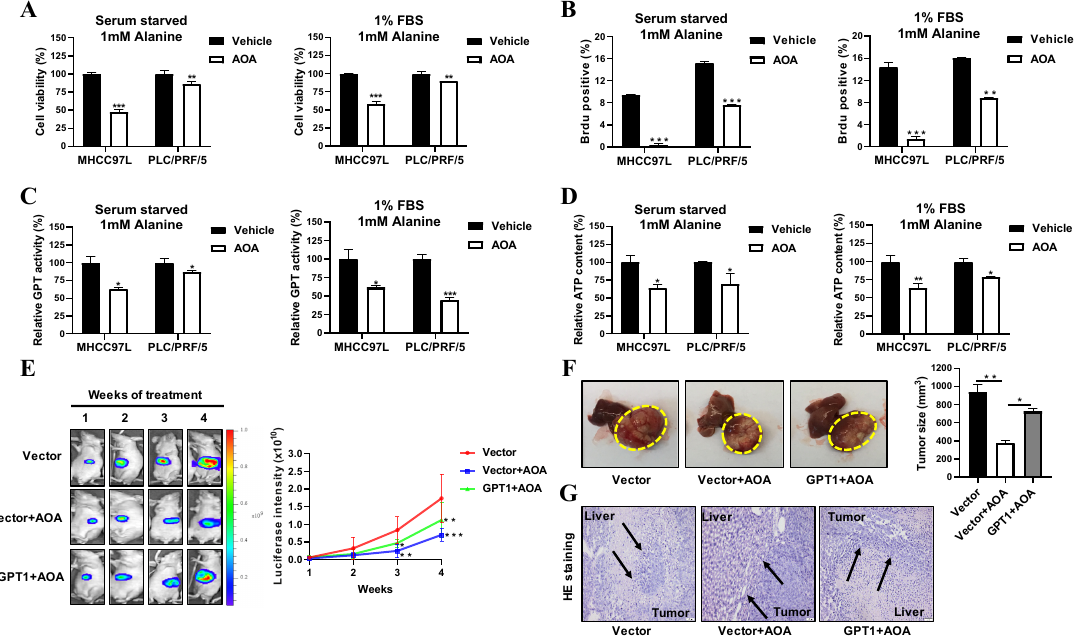
Figure 3. Inhibition of GPT1 with AOA (aminooxyacetate) potently suppressed alanine-mediated HCC growth. ( A ) The cell viability analysis of MHCC97L and PLC / PRF / 5 cells under alanine-rich conditions following AOA treatment for 24 h. ( B ) The BrdU incorporation analysis of MHCC97L and PLC / PRF / 5 cells under alanine-rich conditions following AOA treatment for 24 h. ( C ) The GPT activity levels of MHCC97L and PLC / PRF / 5 cells under alanine-rich conditions following AOA treatment for 24 h. ( D ) The ATP content levels of MHCC97L and PLC / PRF / 5 cells under alanine-rich conditions following AOA treatment for 24 h. ( E ) The representative images and statistical graph of tumor growth with or without stable GPT1 overexpression based on luciferase signals during the AOA treatment ( n = 5). ( F ) The representative images and statistical graph of tumor size with or without stable GPT1 overexpression at the end of AOA treatment ( n = 5). ( G ) The representative H&E staining images of the boundary of tumor and liver tissues with or without stable GPT1 overexpression at the end of AOA treatment ( n = 5). All experiments were conducted in triplicate unless otherwise stated. * P < 0.05, ** P < 0.01, *** P <